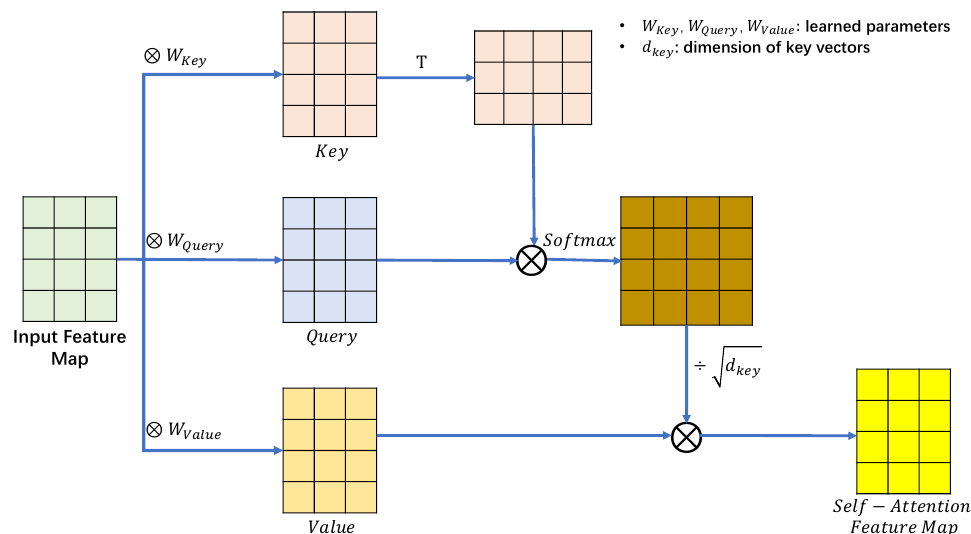
Figure 9. The operating principle of self-attention